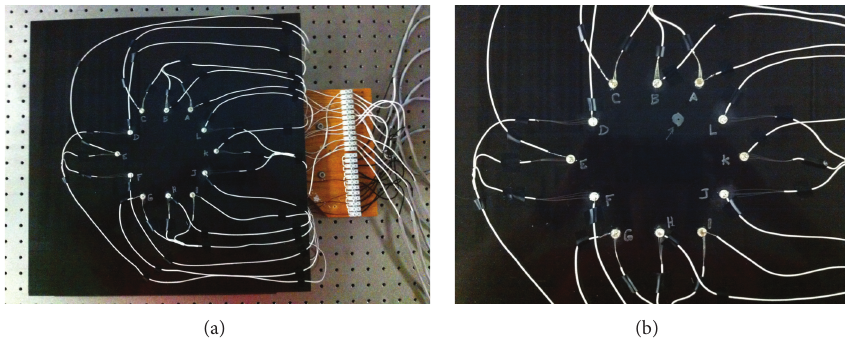
Figure 2: (a) Composite panel with hex network (left) and (b) hex network with induced damage (right).